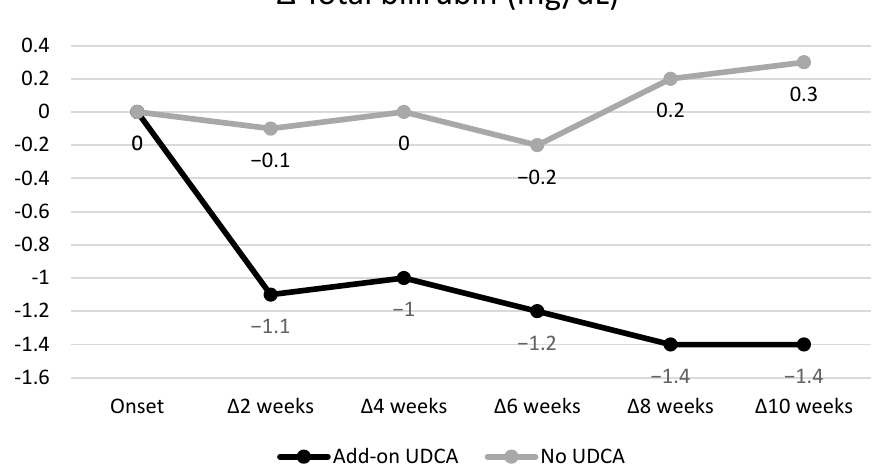
Figure 2. Comparison of the amount of total bilirubin (TB) changes between groups with and without add-on ursodeoxycholic acid (UDCA). The amount of TB depletion was significantly larger in the add-on UDCA group than in the no UDCA group.